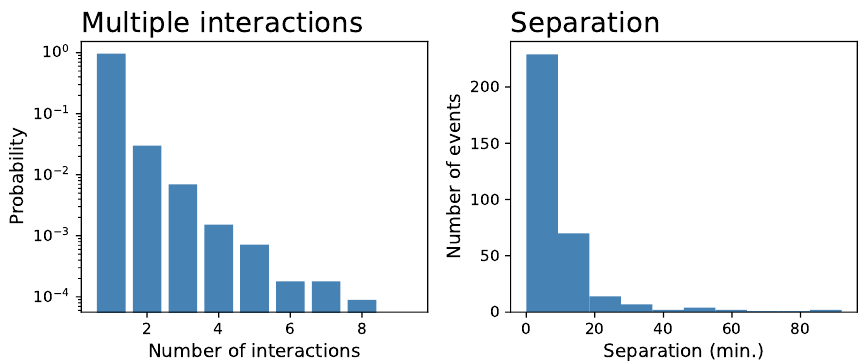
Figure A2. Analysis of the cases in which pairs of aircraft undergo multiple interactions. The left panel reports, for the executed trajectories of 1 September 2018, the probability of finding pairs of aircraft interacting multiple times, for ρ = 10 NM and a vertical separation of 2000 feet. The right panel depicts a histogram of the time separation, in min, between consecutive interactions, for those pairs of aircraft that have interacted twice.